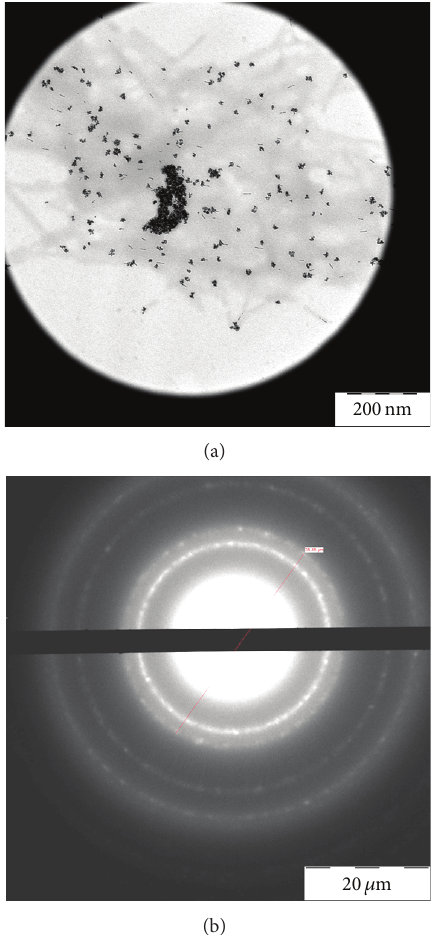
Figure 2: Electron diffraction of the Pt-NPs-TMV preparation. Large area image of the sample in Figure 1(b) concentrated on the specimen grid and its electron diffraction ((a) and (b),